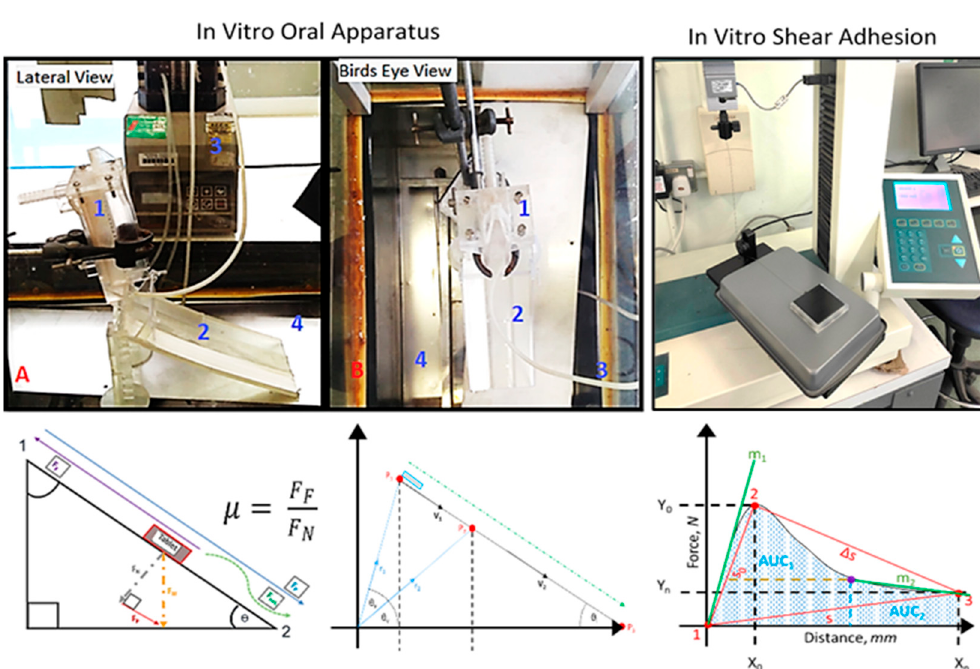
Figure 1. Illustration of basic friction–adhesion model using the in vitro oral apparatus ( left , A —lateral view, B —birds eye view) and in vitro shear adhesion device ( right ) and respective free body diagrams used to determine critical swallowability factor’s coefficient of sliding friction and work of adhesion. The in vitro oral apparatus required tablets to be introduced via an entry slot unwetted (1), a gated mechanism separated the tablet from the wetted ramp (2) maintained by a peristaltic pump (3), and a plexiglass environmental chamber (4) mounted onto a steam bath maintained the internal conditions, i.e., temperature (37 ± 2 °C) and humidity (65% relative humidity). The in vitro shear adhesion device used a 3DP tablet holder to affix 9 tablets on the underside to be dragged at a defined speed across a mucosa-mimicking surface (sodium polyacrylate or polytetrafluoroethylene (PTFE)). A frictionless and 10 N load cell was used to improve recording